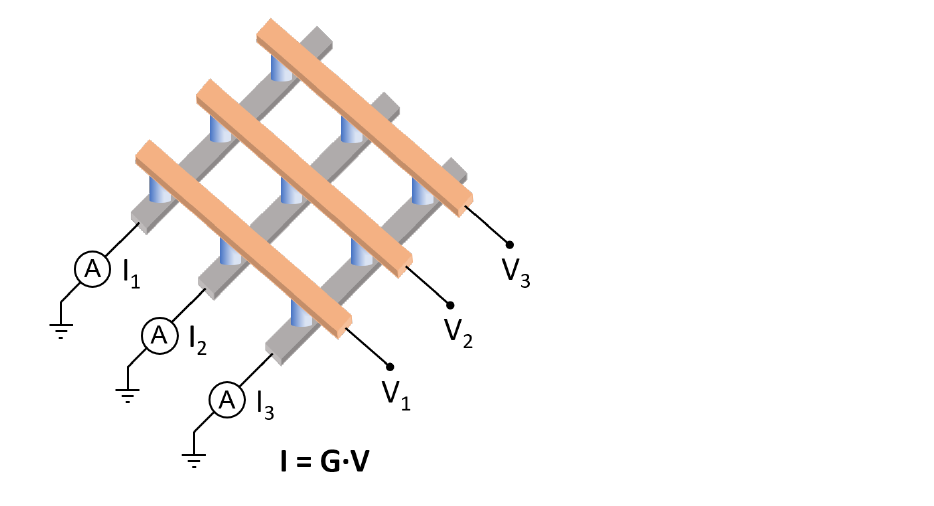
G ij V i . Adapted from i = 1